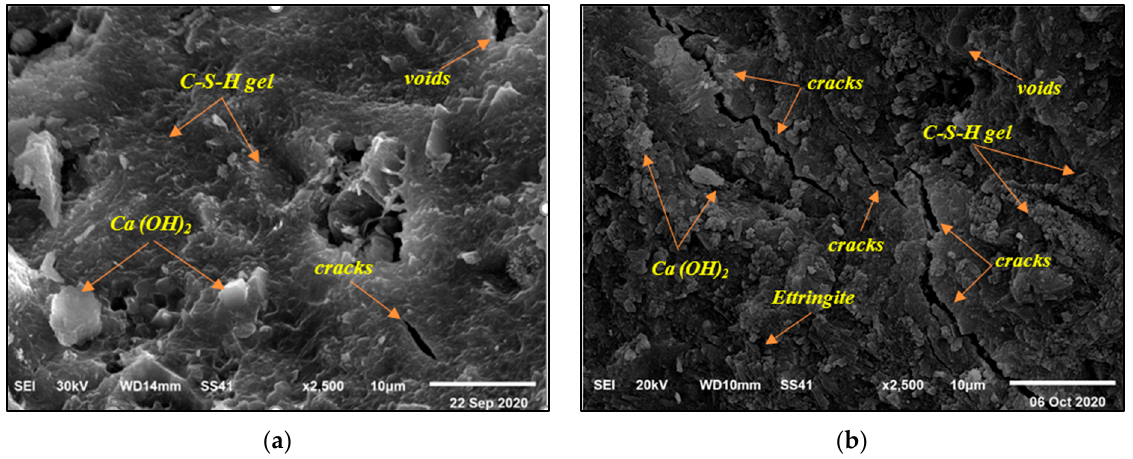
Figure 9. SEM images at 180 days: ( a ) mix BFC450-0.4, and ( b ) mix